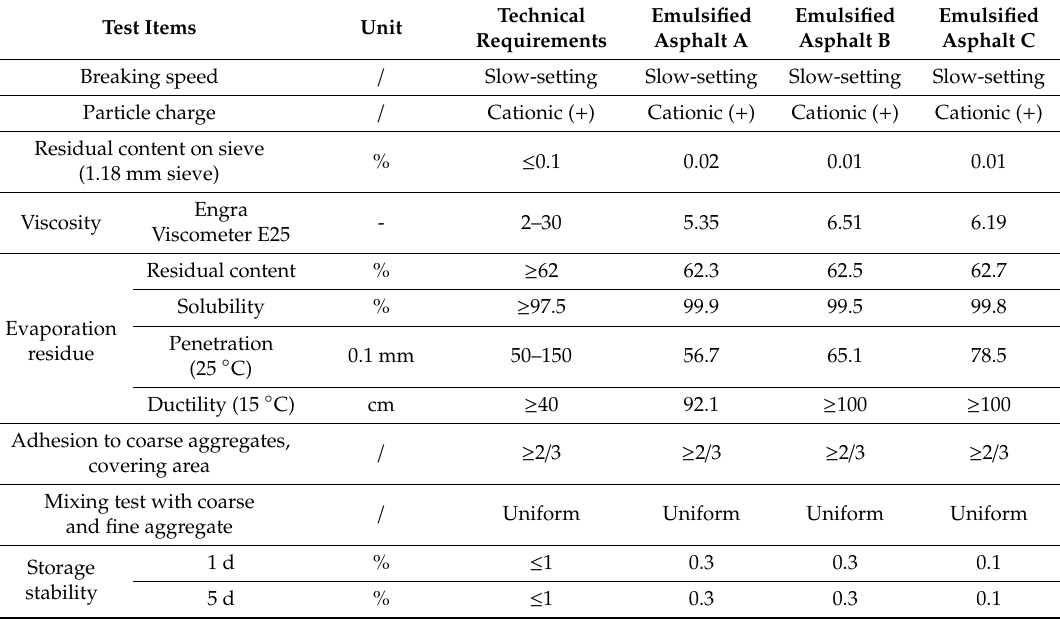
Table 1. Technical requirements and test results of emulsified asphalt.